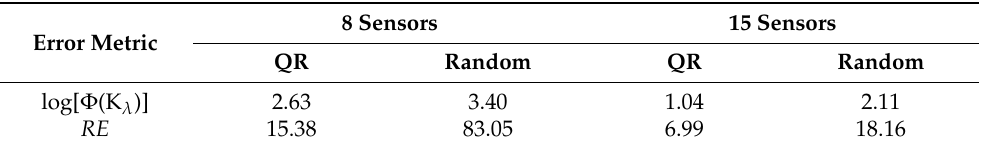
Table 7. Logarithm of condition number of K λ and relative reconstruction errors (%) of random placement and QR pivoting in pressure field (Boundary Condition